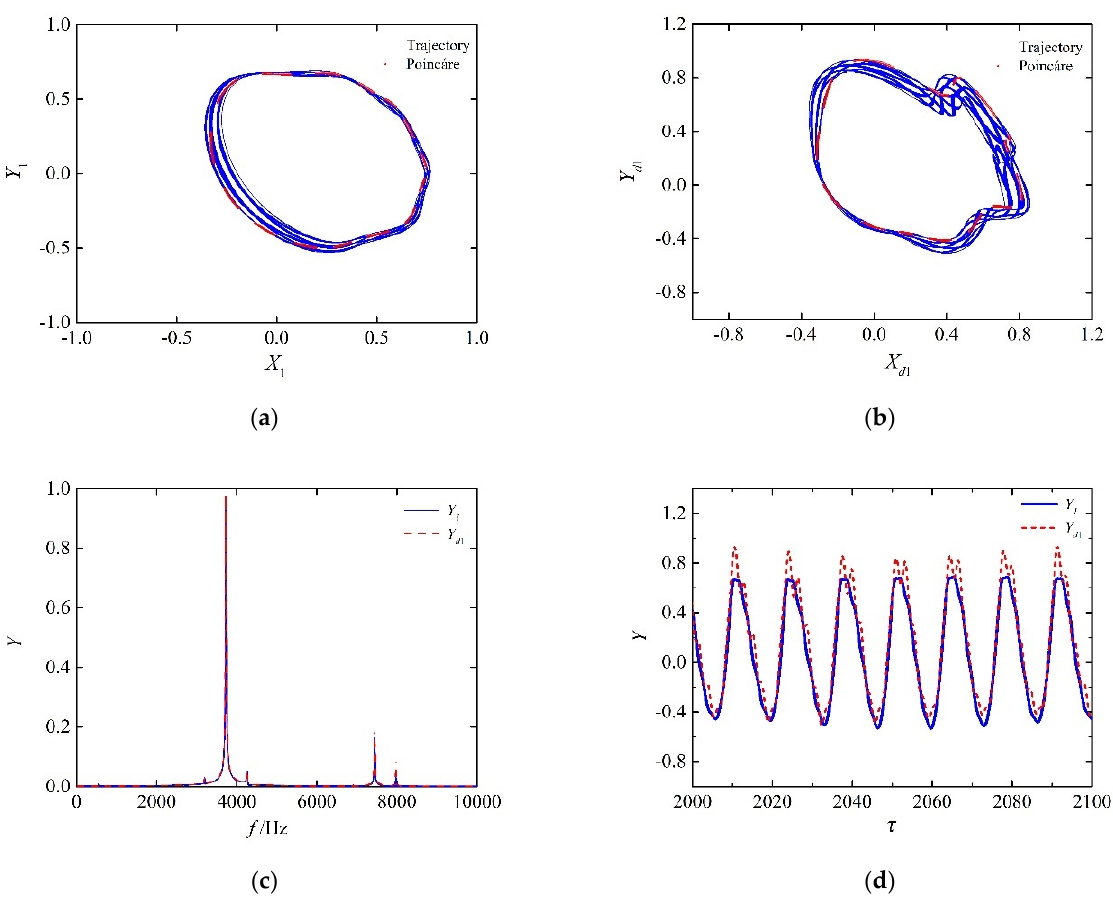
Figure 8. Quasiperiodic motion of rod–fastened rotor at ω = 2000 rad/s: ( a ) orbit and Poincaré map at the left bearing station; ( b ) orbit and Poincaré map at the left disk station; ( c ) comparison of spectrogram at the left disk and left bearing stations; ( d ) comparison of the time series diagram at the left disk and left bearing stations.